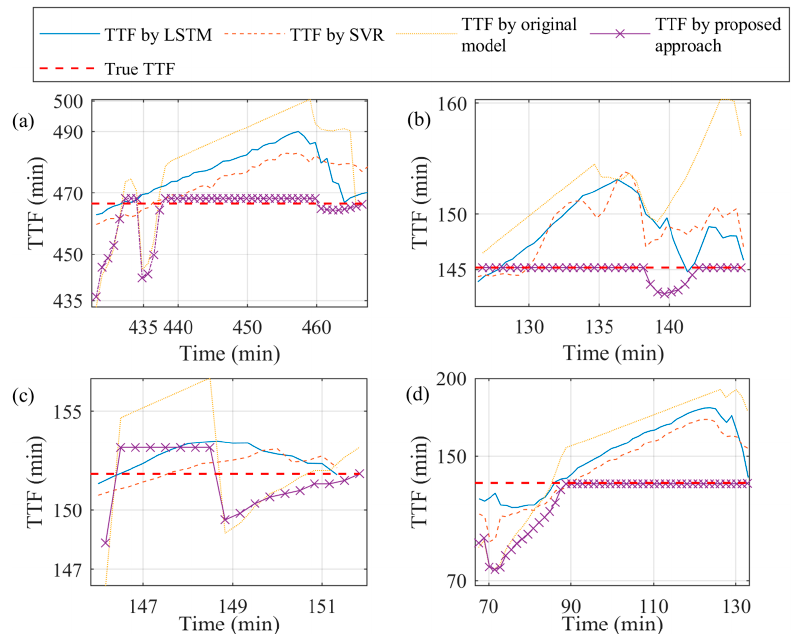
Figure 14. TTF prediction results of different approaches for ( a ) bearing 1_1, ( b ) bearing 1_2, ( c ) bear- ing 2_1, and ( d ) bearing